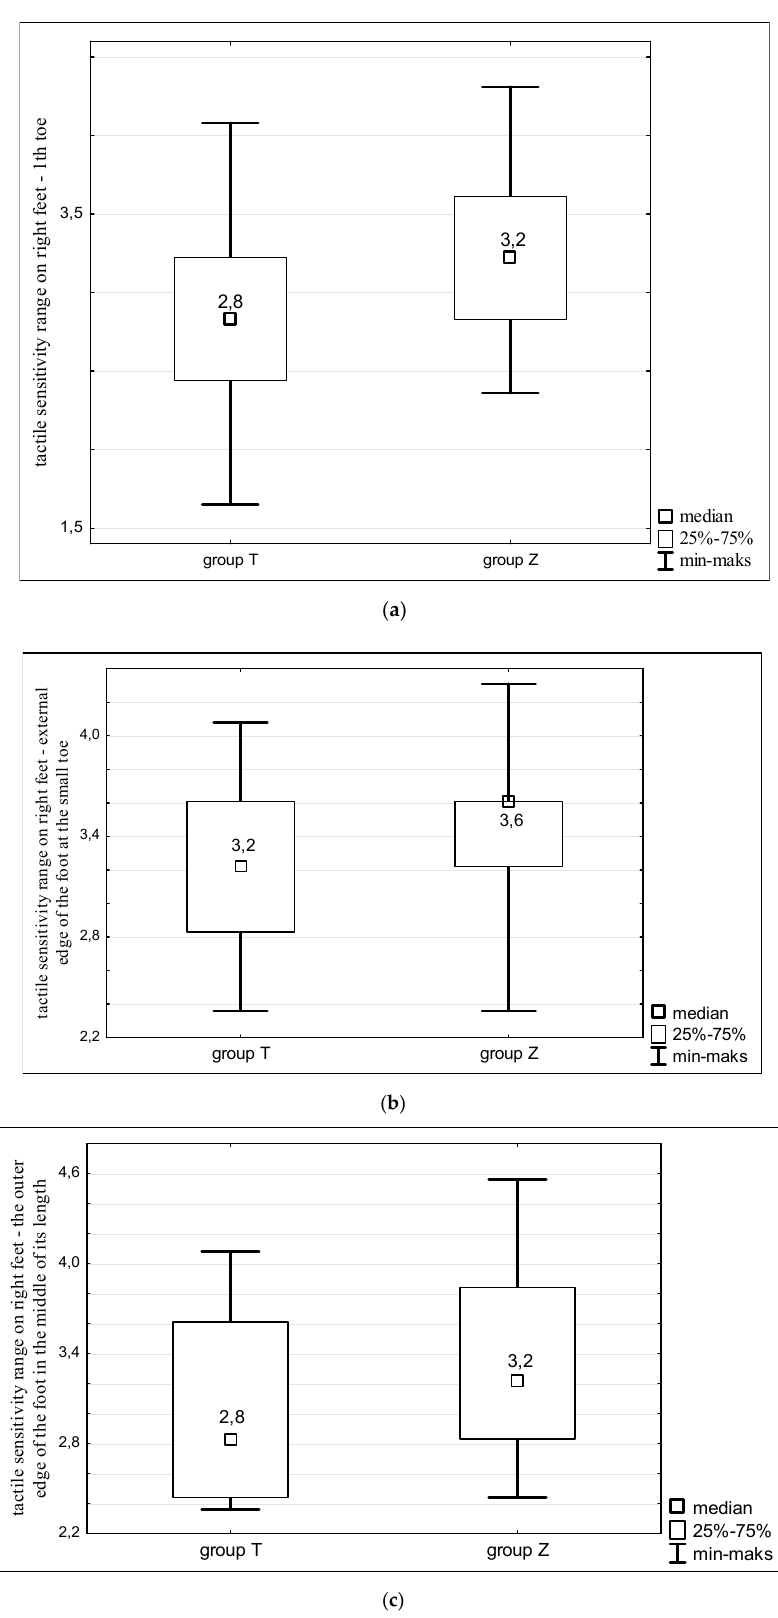
Figure 3. Tactile sensitivity of right feet of women with Turner syndrome (group T) and healthy women (group Z). Sensitivity measurements taken at: ( a ) the first toe; ( b ) external edge of the foot at the small toe; and ( c ) the outer edge of the foot in the middle of its length. The left feet of the studied women also showed differences in tactile sensitivity. Statistically significant differences were noted in the sensitivity threshold of the first toe ( p < 0.001) and in the middle on the outer edge of the left foot ( p < 0.05) (Figure 4). In all cases sensitivity of the feet was greater in Turner syndrome patients.